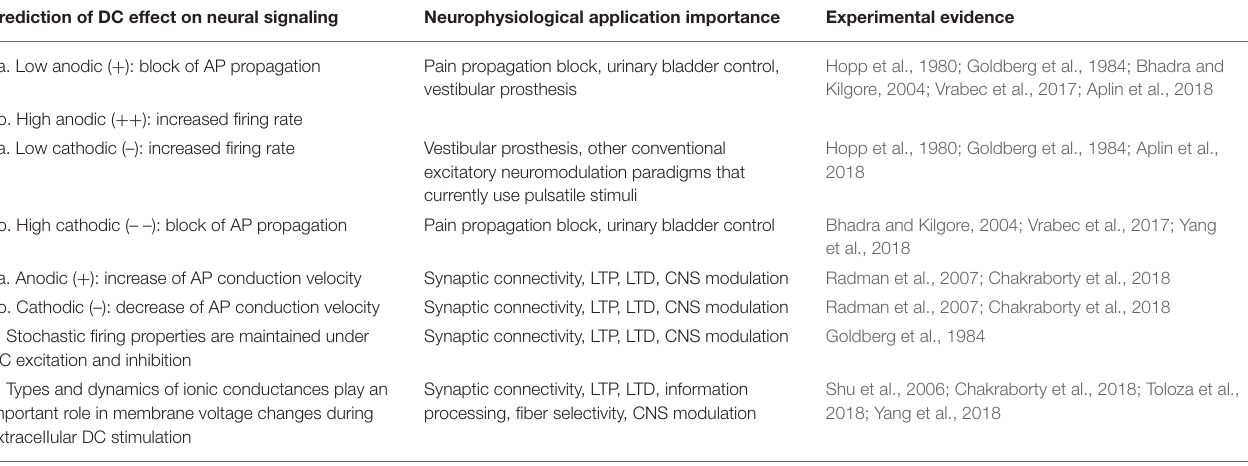
TABLE 1 | Summary of DC effects on neurons from both intuitive predictions suggested by the Mirror Estimate model and experimental evidence. Prediction of DC effect on neural